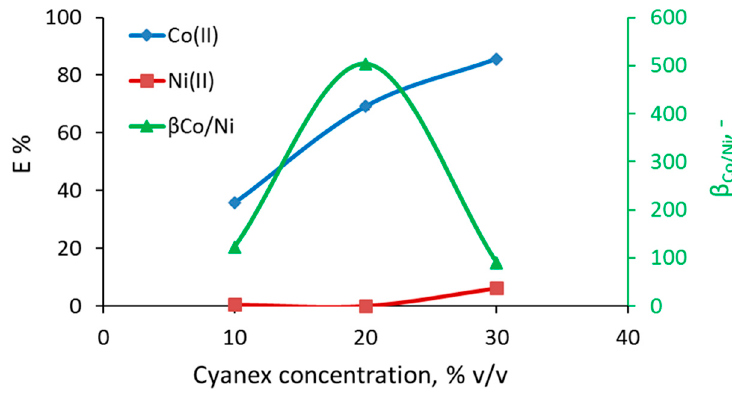
Figure 5. E ff ect of Cyanex 272 concentration (% v / v ) on the extraction percentage of Co(II) and Ni(II), and separation factor between Co(II) and Ni(II), at pH eq = 4.5 (30% pre-neutralization).